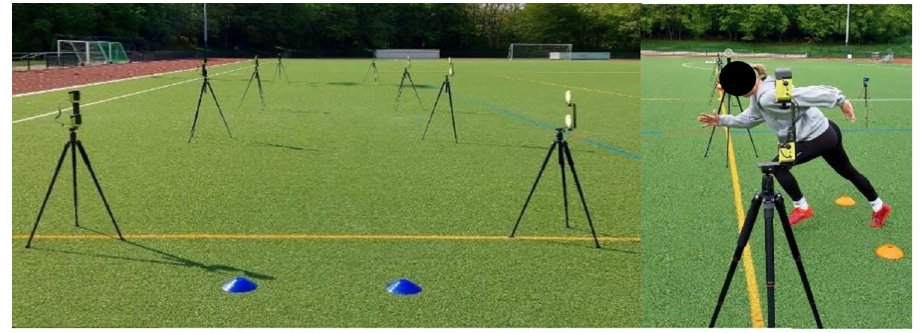
Fig 1. Sprinting